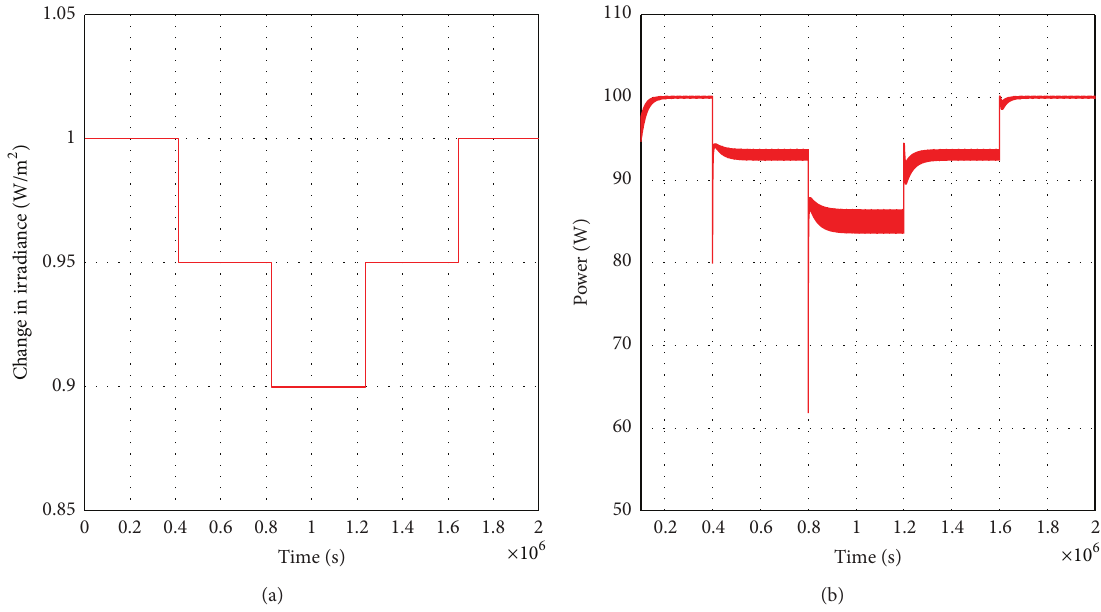
Figure 6: (a) shows varying irradiance level and (b) shows maximum power due to irradiance variation.